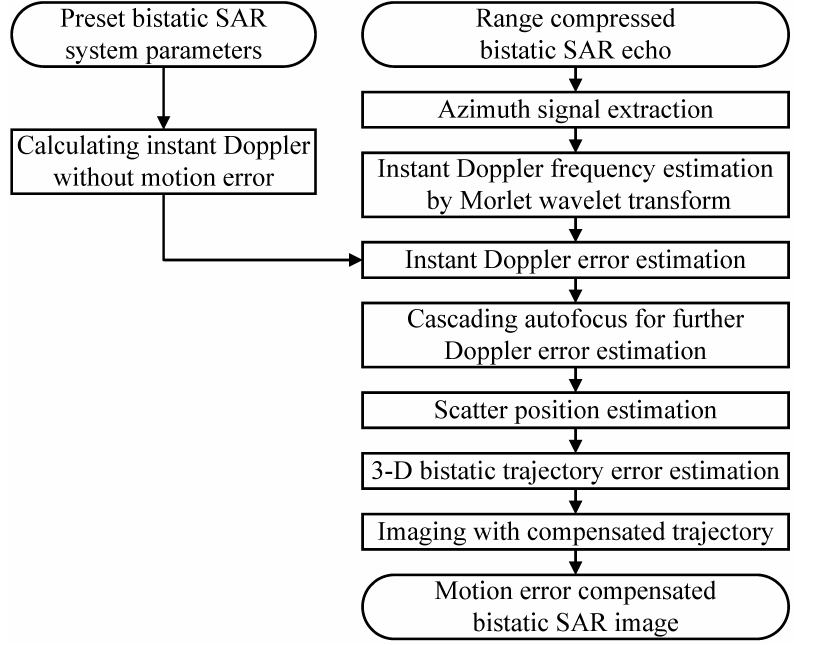
Figure 4. Procedure of the proposed bistatic SAR trajectory error estimation and compensation